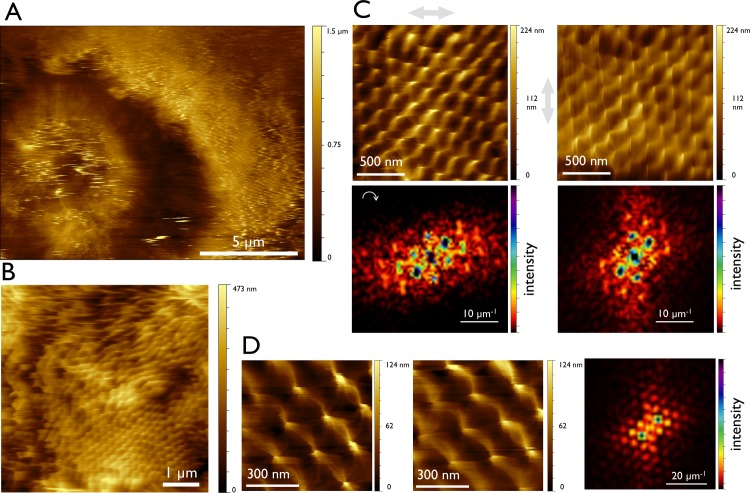
AFM images of the rhombic lattice arrangement of microvilli—AC mode.Series of the same area of Caco-2 cells at different magnifications. (A) Overview of Caco-2 cells recorded with 1024 data point per scan line. At this image size the amplitude set point must be decreased to image the whole range in z of 1.5 μm. This leads to adhesion of the tip at some areas. (B) This resolution can detect highly and less ordered arrangements of microvilli. (C) With a lateral resolution of 6–7 nm/px the lattice arrangement can clearly be identified. Presented are 0 and 90 degree images of the same area (scan direction labelled with light grey arrow) and their Fourier transforms. For better comparison the left Fourier image is rotated as marked by the white arrow. (D) At the highest magnification of 2.9 nm/px the intermicrovillar links are visible in detail. A repeated scan is presented to demonstrate image stability. Furthermore the Fourier transform at this level yields to the presentation of harmonic components in the Fourier transformation.